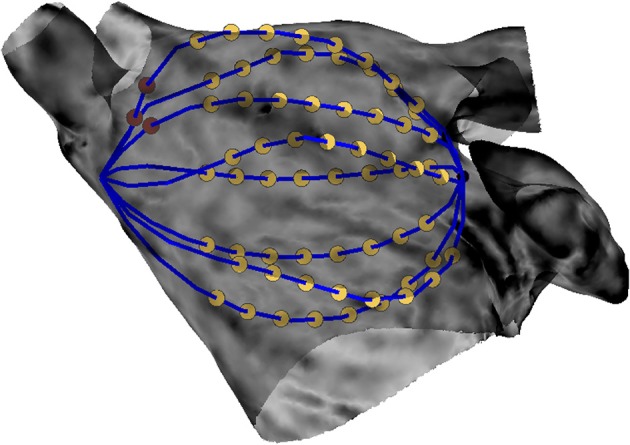
Simulated basket catheter within the LA geometry. Yellow dots denote the 64 electrodes of the catheter. Blue lines illustrate the catheter's splines. One and two red dots indicate the proximal end of spline A and spline B, respectively.